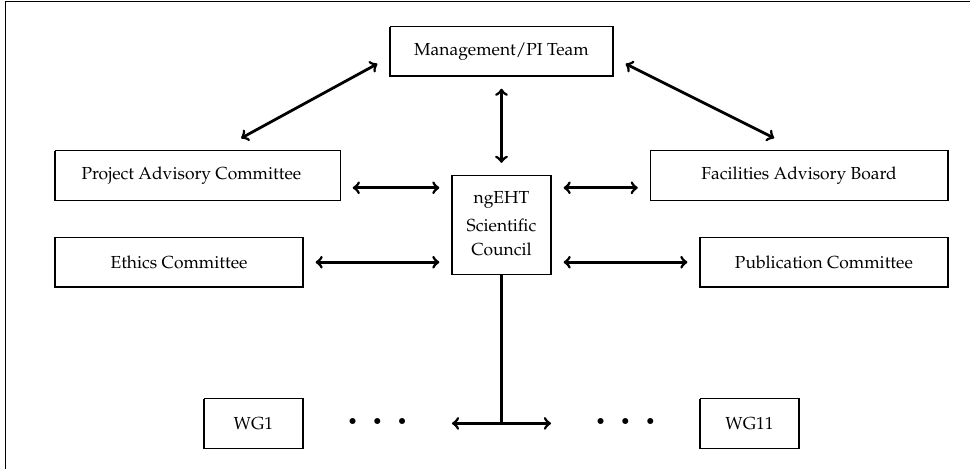
Figure 1. Tentative governance structure of the ngEHT